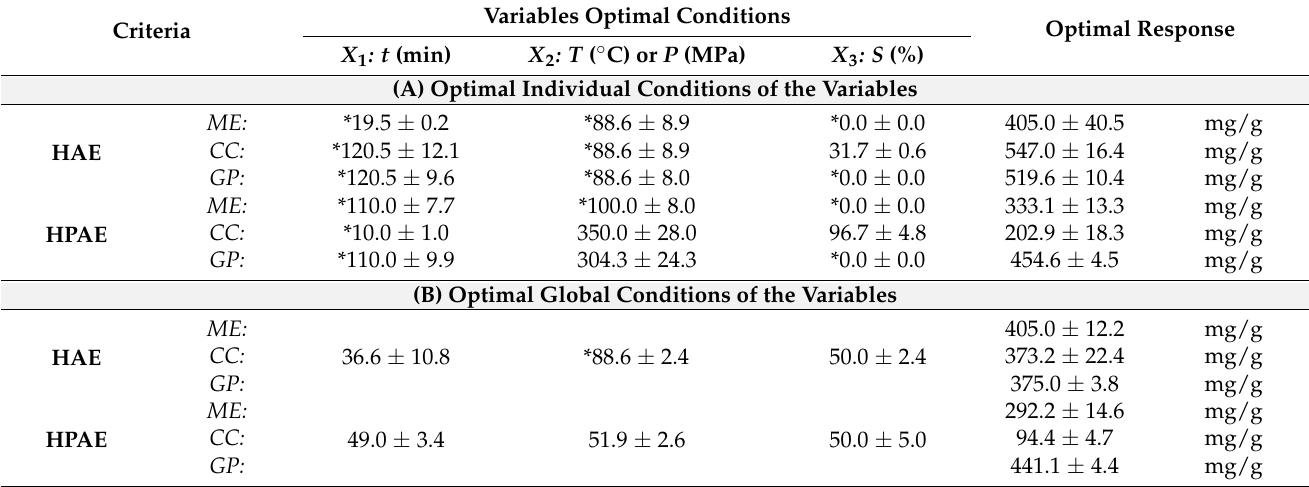
Table 6. Absolute or relative conditions (marked with *) of the variables in natural values that lead to optimal response values ( Y, yield ) for RSM using CCCD for each of the extraction techniques (HAE and HPAE) and for each of the alga ( Y ME , Y CC and Y GP